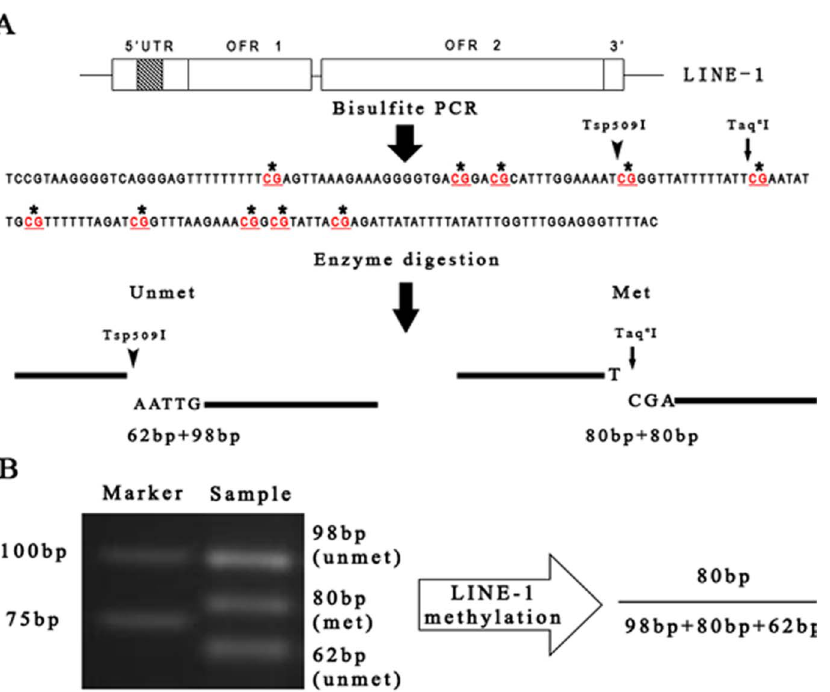
Figure 1. Schematic diagram of combined bisulfite restriction analysis (COBRA) of LINE-1. A . Intact LINE-1 is approximately 6 kb long, and comprised of 5 9 -untranslated region (5 9 UTR), two opening reading frames ORF1 and ORF2 and 3 9 UTR. After bisulfite conversion of genomic DNA, PCR was performed to amplify a region of 160 bp in 5 9 UTR (gray region with oblique lines) harboring 10 CpG sites (marked by asterisks). The site at 62 bp is cut by Tsp509I (target at ‘ AATT) when CpG is unmethylated, yielding fragments of 62 bp and 98 bp (marked as unmet). The site at 80 bp is cut by Taq a I (target at T ‘ CGA) when CpG is methylated, yielding two fragments of 80 bp each (marked as met). B . After digestion with restriction enzymes, PCR products were separated by electrophoresis in 2.3% agarose gels. DNA bands were visualized and subject to densitometry analyses. The LINE-1 methylation level is calculated as the percentage of the intensity of Taq a I-positive fragment in total DNA.